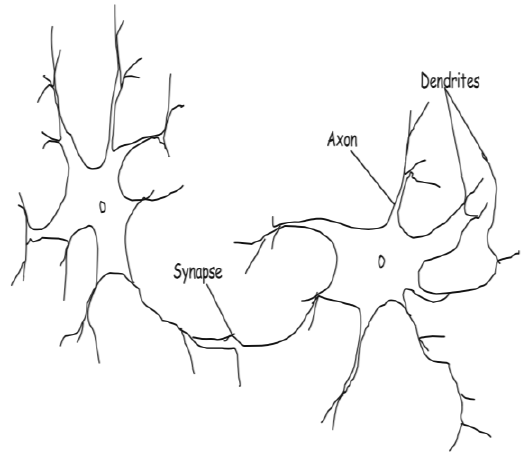
Figure 1: Biological Neuron (Le and Juszczyk, 2018)